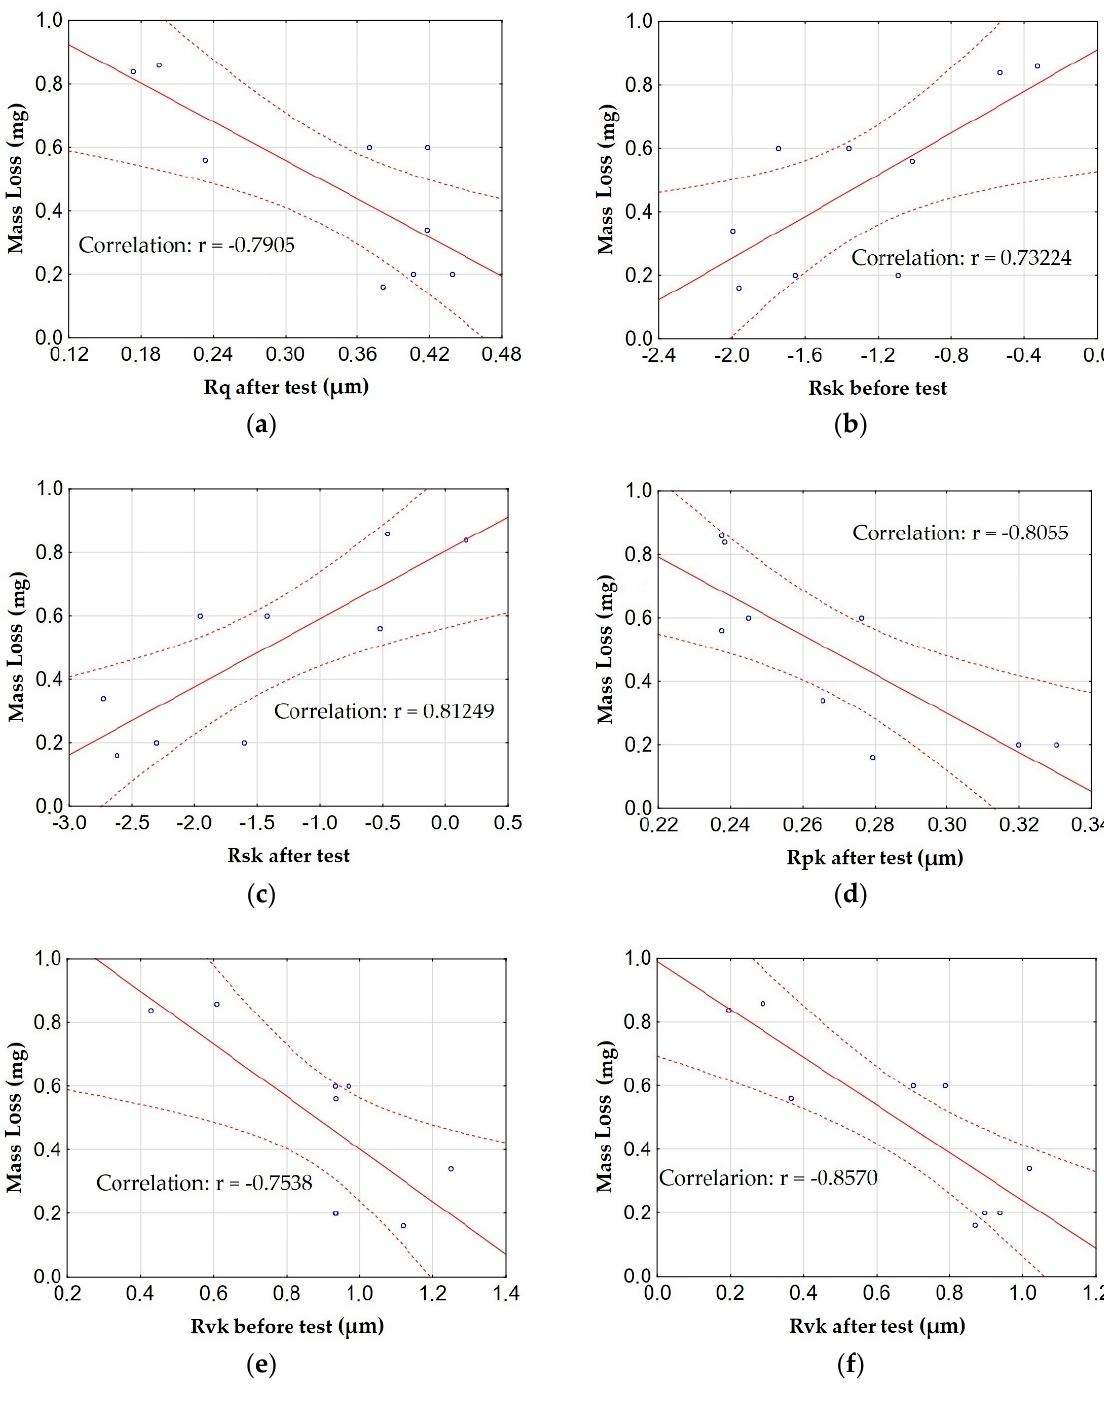
Figure 11. Relationships between the mass loss of T7W material and: ( a ) the Rq parameter after the test, ( b ) the Rsk parameter before the test, ( c ) the Rsk parameter after the test, ( d ) the Rpk parameter after the test, ( e ) the Rvk parameter before the test, ( f ) with the Rvk parameter after the test. Figure 12 shows the graphs of the relationship (correlation) between the friction coefficient µ and the amplitude parameters and the load-bearing curve with the highest